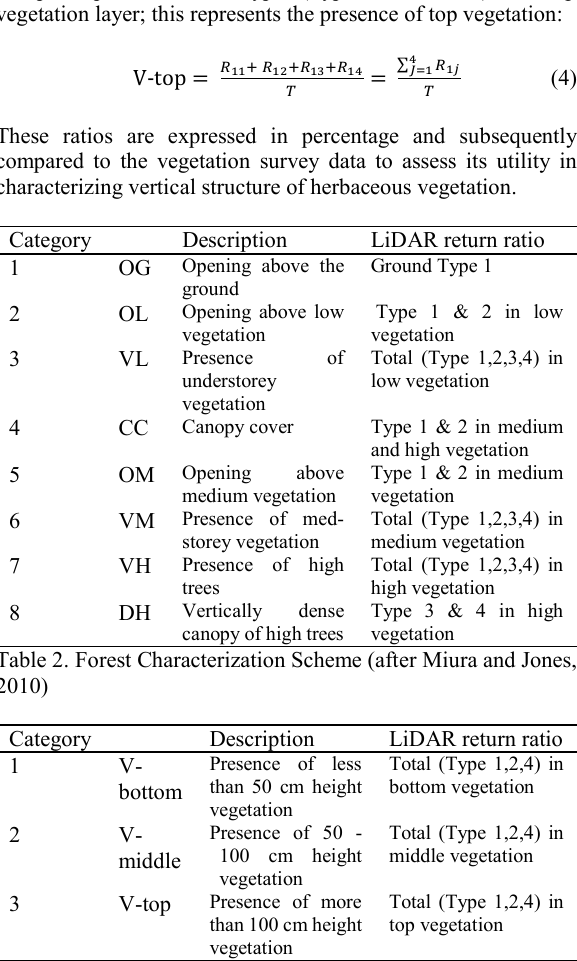
Table 3. Modified characterization scheme to derive vertical structure of herbaceous vegetation